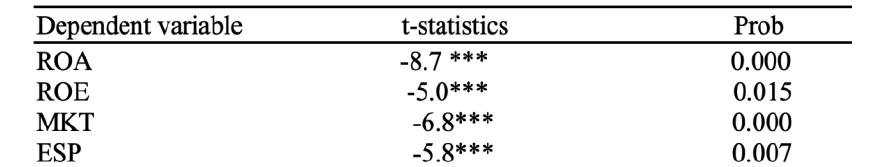
Table 6: Test of